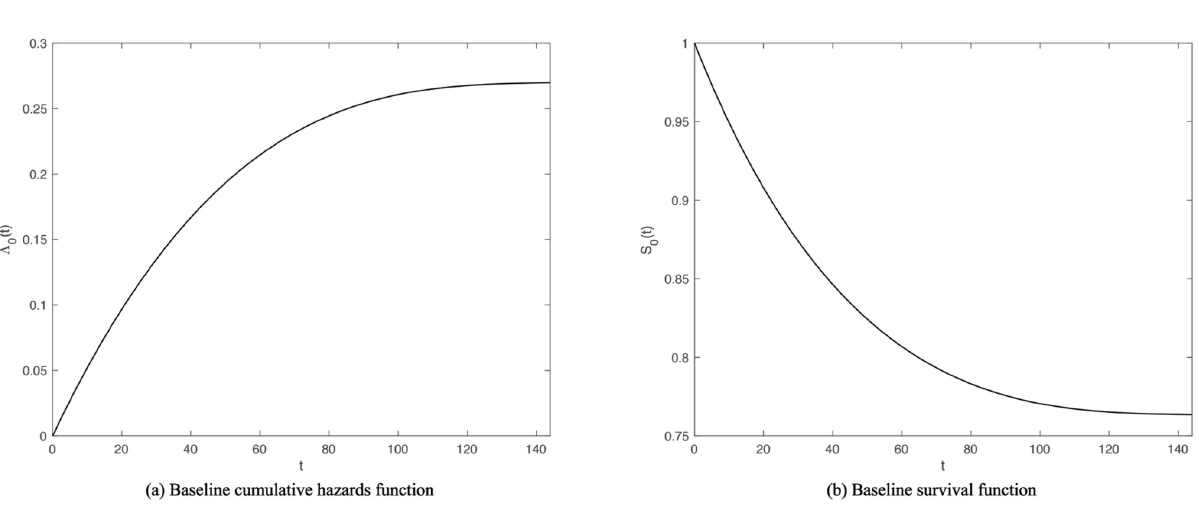
Fig 5. Estimated baseline cumulative hazards function and baseline survival function of children in survey. Note that t is measured in months. We see that the hazards function curve and survival function curve become flat as children grow up, which is consistent with reality.